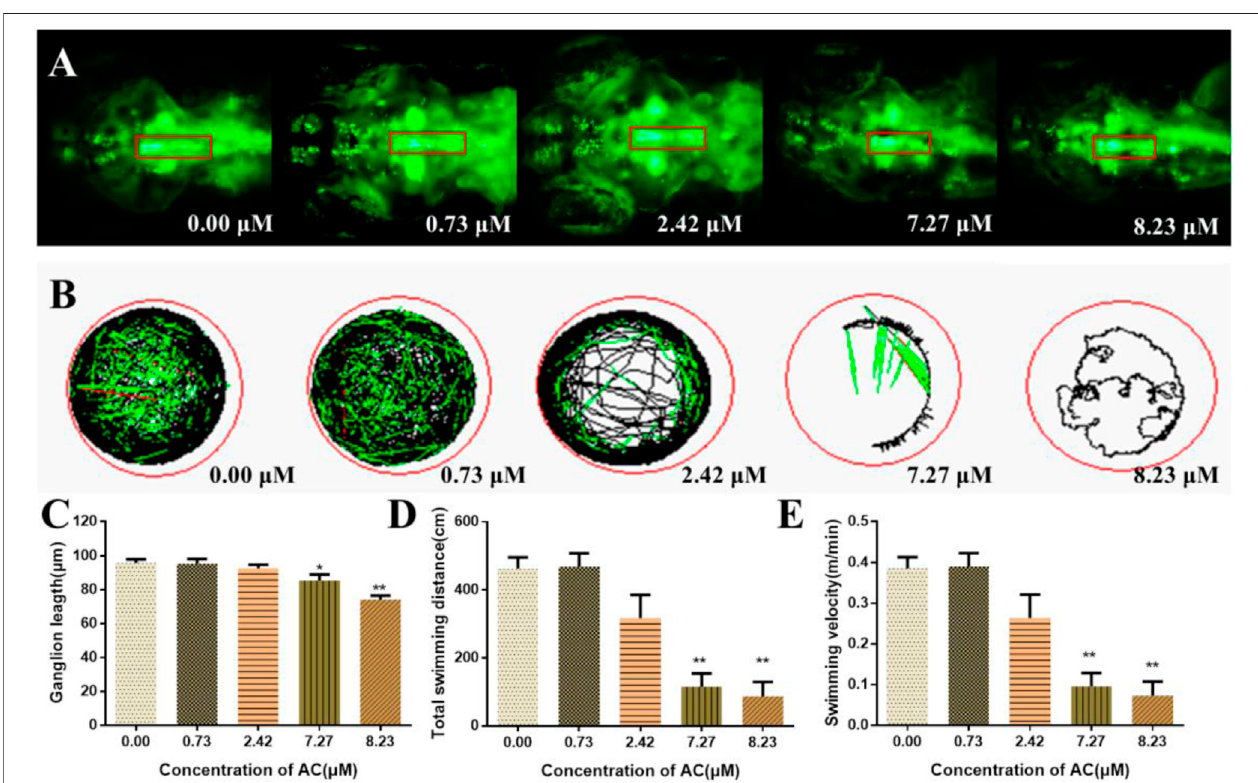
FIGURE 4 | Effects of AC on developing nervous systems. (A) Dorsal view fl uorescence images of 96 hpf Tg(Vmat:GFP) embryos show dopaminergic neurons of brain. The red box represents the raphe nuclei cluster of dopaminergic/vesicular monoamine transporter 2 – positive neurons. (B) Tracking images of larval swimming activity reduced gradually with the doses increasing at 7 dpf. (C) Length of dopamine ganglion at 96 hpf. (D) Total swimming distance of embryos at seven dpf. (E) Swimming velocity of embryos at 7 dpf. Values are expressed as mean ± SD ( n (cid:1) 10). * p < 0.05 and ** p < 0.01 vs. control.